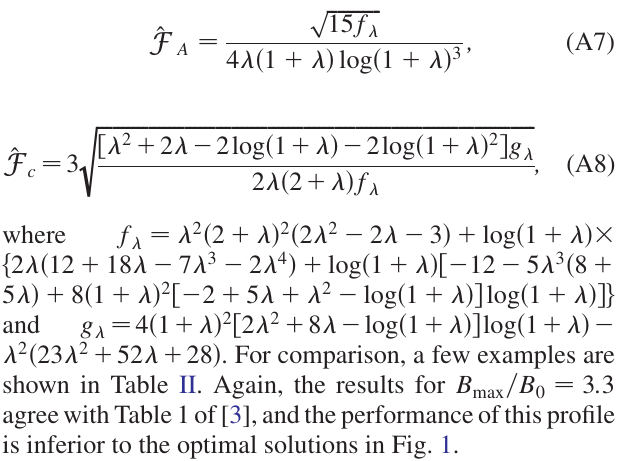
form expressions